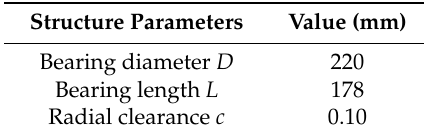
Table 1. Main structure parameters of the test bearing.